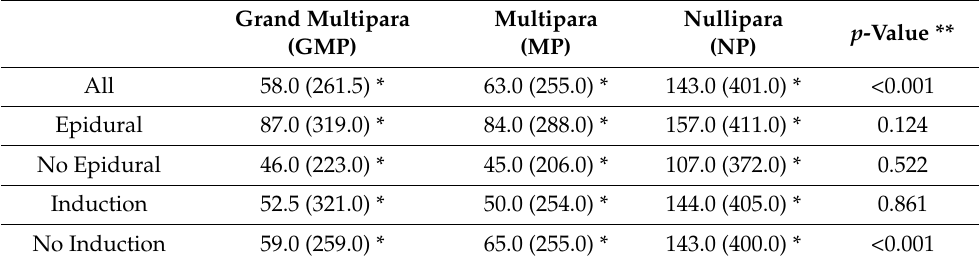
Table 5. Duration of active phase of first stage of labor.